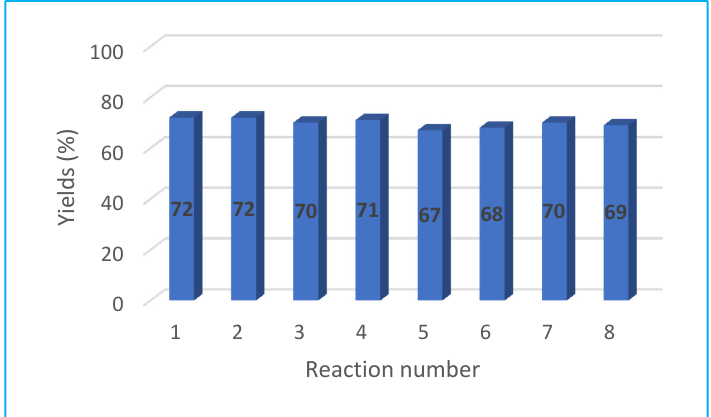
Figure 3. Use of MoO 2 Cl 2 (H 2 O) 2 in consecutive reductive depolymerizations of P4HB. The reactions were carried out using MoO 2 Cl 2 (H 2 O) 2 (5 mol%) by successive additions of P4HB (0.5 mmol) and TMDS (1.5 mmol) to the reaction mixture, without separating the catalyst at the end of each reaction. Yields were determined by 1 H NMR spectroscopy, using mesitylene as an internal standard. The reductive depolymerization of polyester PBS, obtained from Delta Q eQo coffee MoO 2 Cl 2 (H 2 O) 2 /silane (Table 2). The depolymerization of PBS was initially investigated using PMHS as the reducing agent and MoO 2 Cl 2 (H 2 O) 2 as the catalyst. The reaction